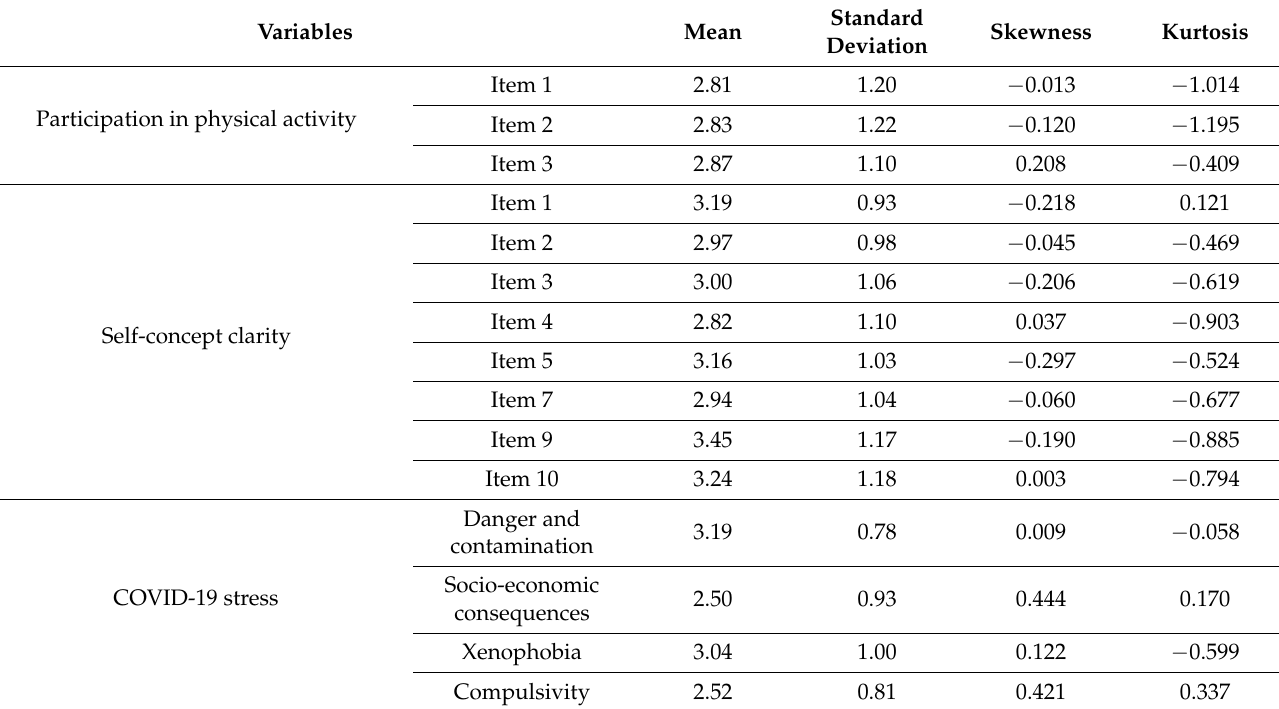
Table 6. Descriptive analysis (full mark: 5.0).